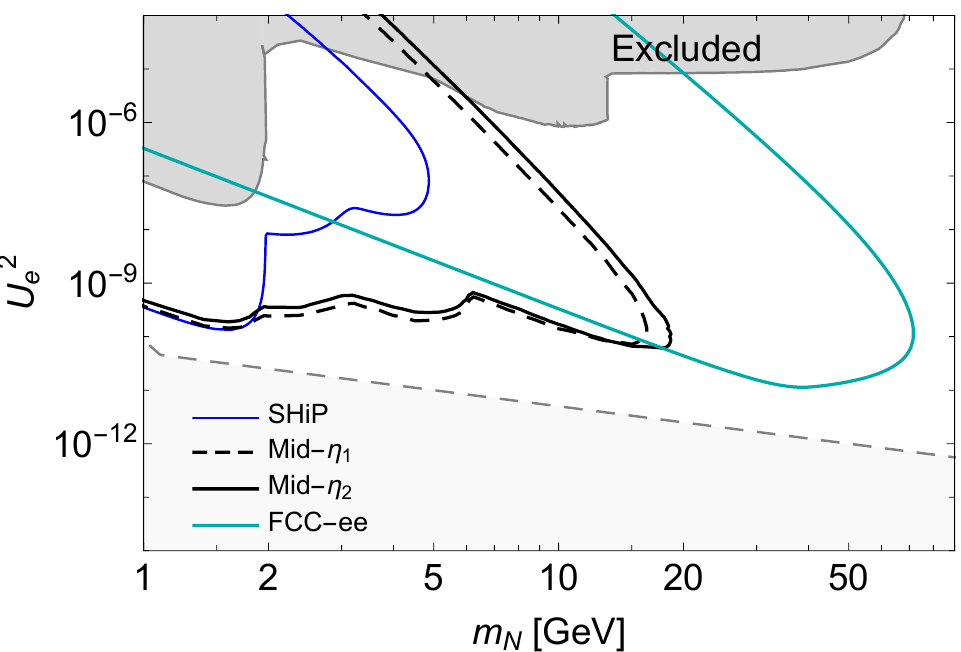
Figure 10 . The sensitivity of future proposed experiments to HNLs mixed solely with ν e : SHiP (from [46]), FCC-ee, and FCC-hh-based experiments proposed in this paper (see section 3.4): mid- η 1 , which covers the domain | η | < 1 . 5 , and mid- η 2 , which covers 1 . 5 < | η | < 2 . 6 . The curves are ob- tained under the assumption of zero background has been assumed (see section 4.2) and at 95%